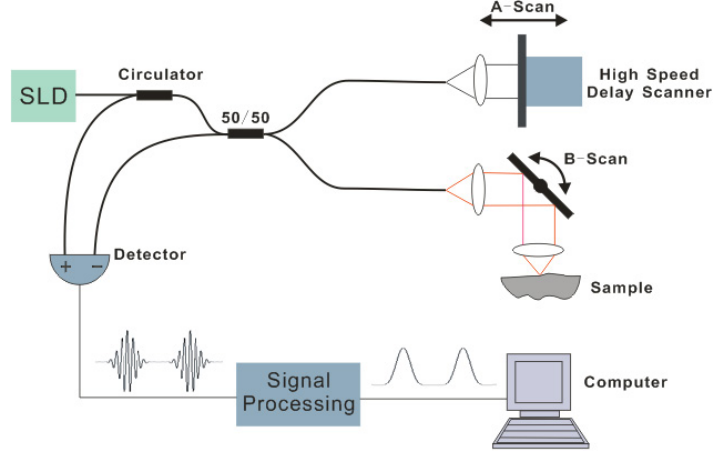
Fig. 1. Schematic diagram to illustrate the TD-OCT